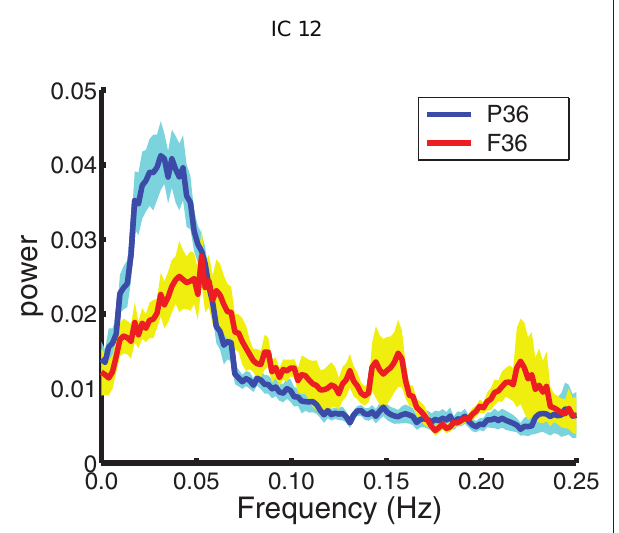
Figure 3 | Spectral analysis of iCA time courses of basal ganglia (iC12) component. Plotted here is the mean spectral power for pre-term children (blue) at 36 months along with their standard errors (cyan) and mean spectral power for full term children (red) at 36 months along with their standard errors